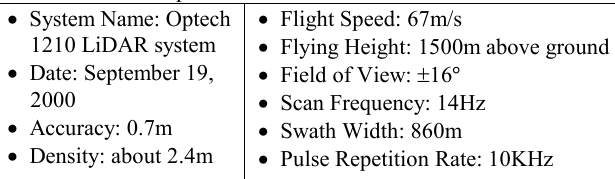
Table 1: Specification for LiDAR data collection